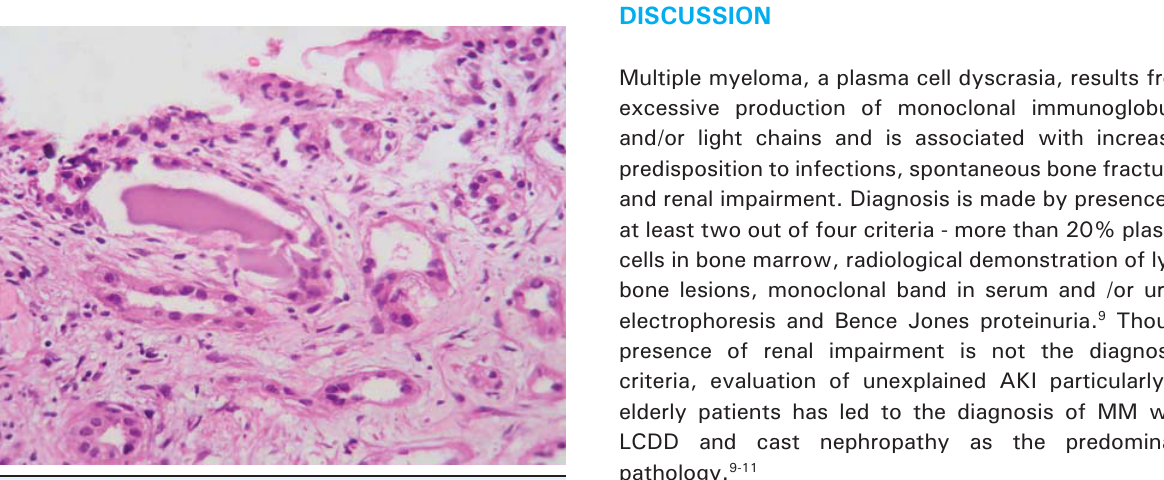
Figure 2. Photomicrograph of renal biopsy with high magni fi cation (40X: H&E stain) of the atypical cast eliciting mild epithelial cell reaction of the tubular epithelial